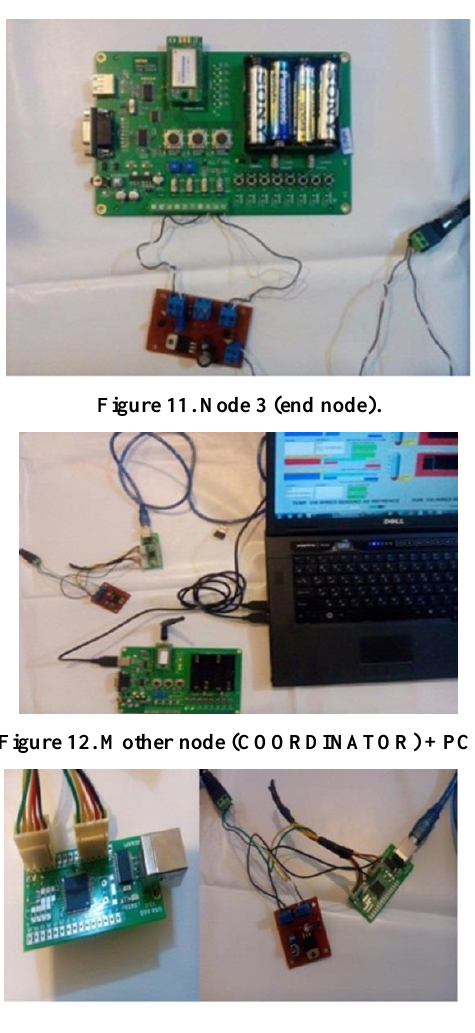
Figure 13. SHT11 digital sensor board + USB